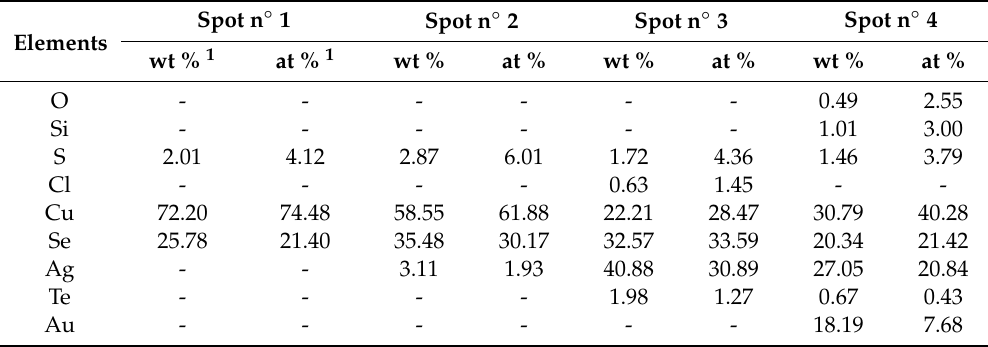
Table 1. Elemental composition of initial CAS analyzed by SEM-EDS.